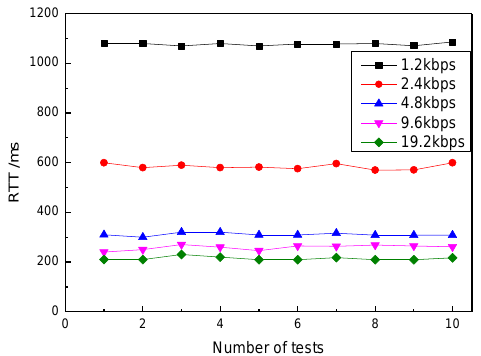
Figure 10. Relationship between RTT and air rate.